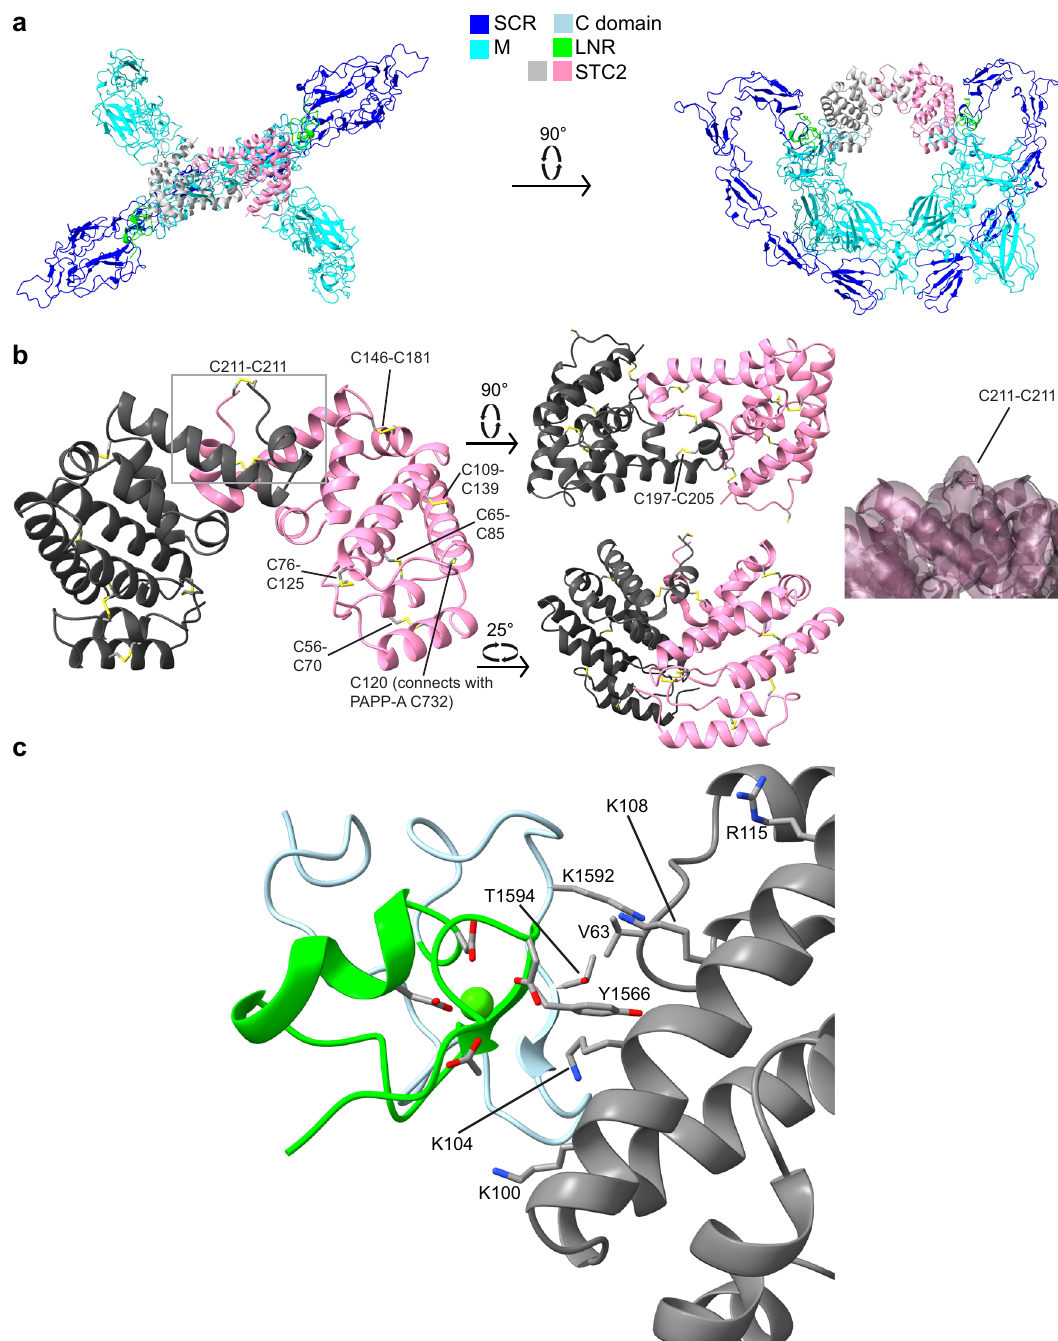
Fig. 7 | The stanniocalcin-2 (STC2) dimer is suspended centrally in the PAPP- A·STC2 structure. a Cartoon representation in two orientations of the PAPP- A·STC2complexwiththeMdomains(cyan),theSCRdomains(blue),theCdomain (light blue) including LNR3 (green), and the STC2 dimer (gray/pink) shown to emphasizethepositionoftheSTC2dimerwithinthecomplex.Thiscolorschemeis usedthroughoutthe fi gure. b